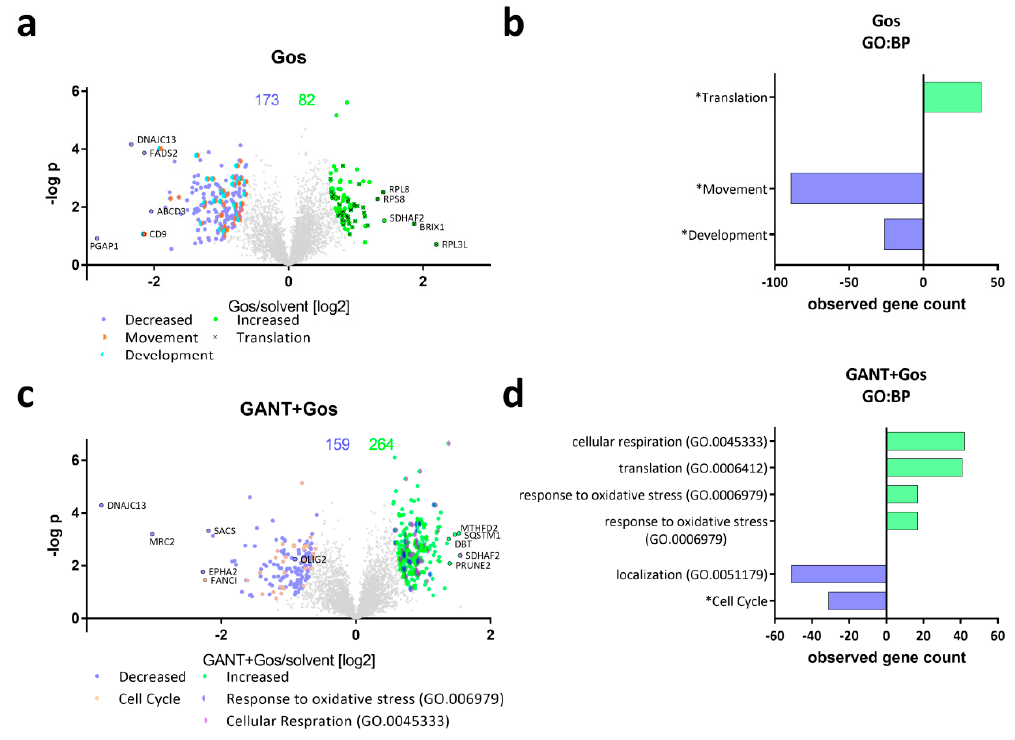
Figure 2. Cont. Figure 2.